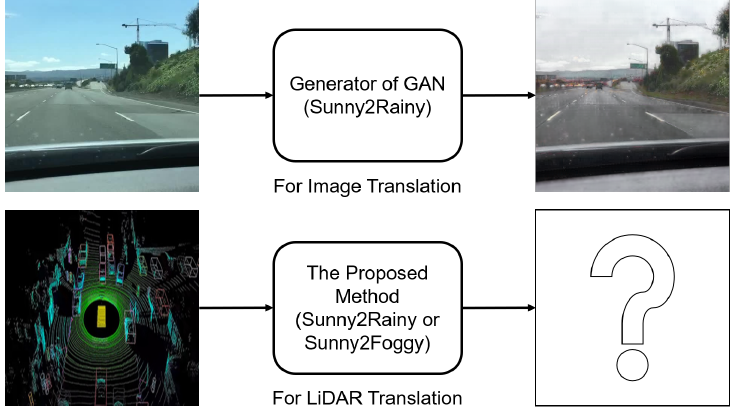
Figure 1. Purpose of the proposed method. As shown in upper figures, GAN-based networks are generally utilized for image translation. Sunny2Rainy indicates the translation from sunny data to rainy data and Sunny2Foggy is that from sunny data to foggy data. We present the first LiDAR-to- LiDAR translation which deals with various adverse weather conditions based on a GAN